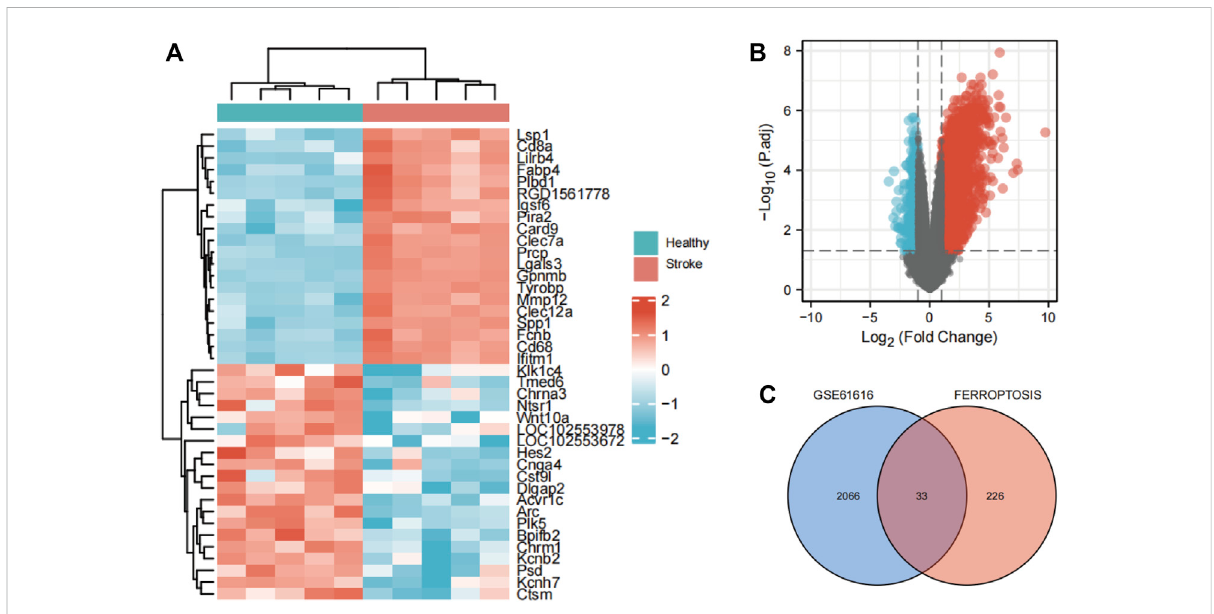
FIGURE 1 Identi fi cation of ferroptosis-related DEGs in IS. (A) Heatmap of DEGs between the MCAO cohort and the sham cohort in the GSE1 dataset. (B) Volcano plots of DEGs. (C) Venn diagram of DEGs from the two